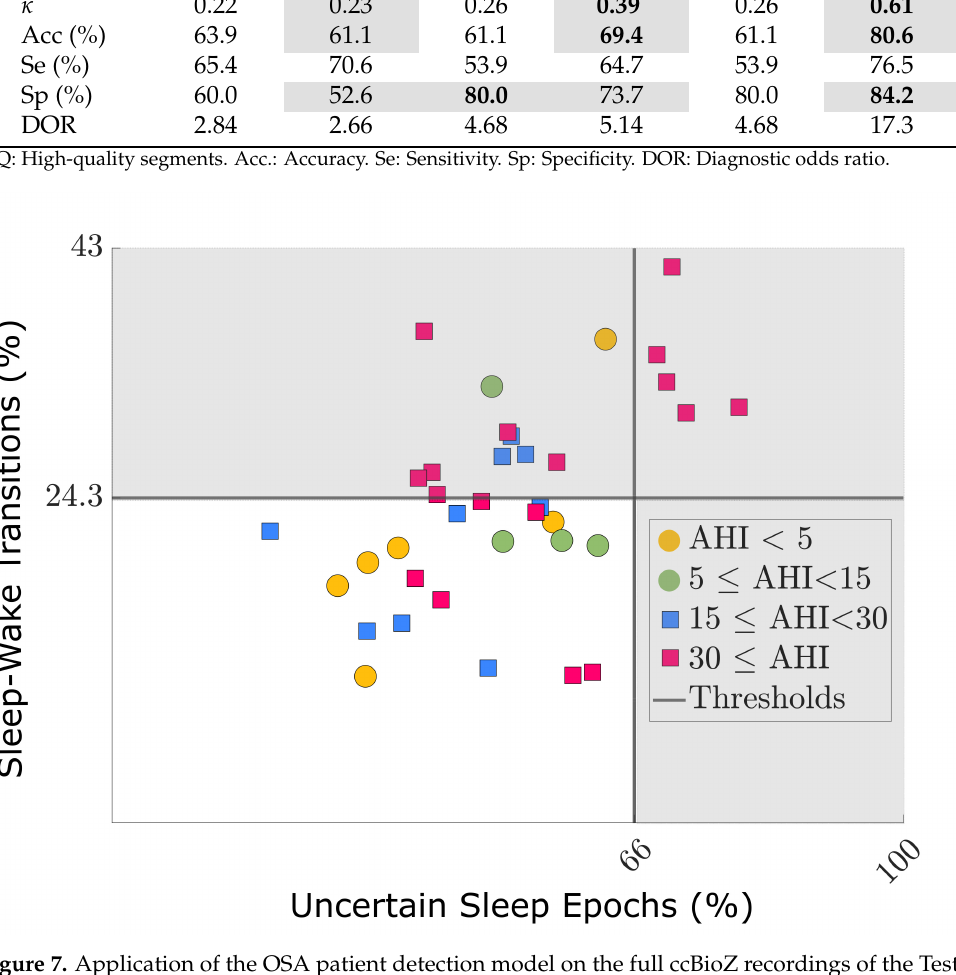
Figure 7. Application of the OSA patient detection model on the full ccBioZ recordings of the Test dataset. Circles represent AHI < 15 and squares AHI (cid:62) 15, and the lines are the index-specific thresholds. The model identified a patient as being at risk of OSA (AHI (cid:62) 15) if at least one of both metrics exceeded a selected threshold (grey area). For this, the model yielded a specificity of 80%. Five of the detected patients exceeded the thresholds of both detection indices (red squares in upper right quadrant), who were identified as being at risk of OSA with 100% accuracy. On the other hand, two patients were falsely detected as being at risk of OSA, indicated as a green and yellow dot in the upper left